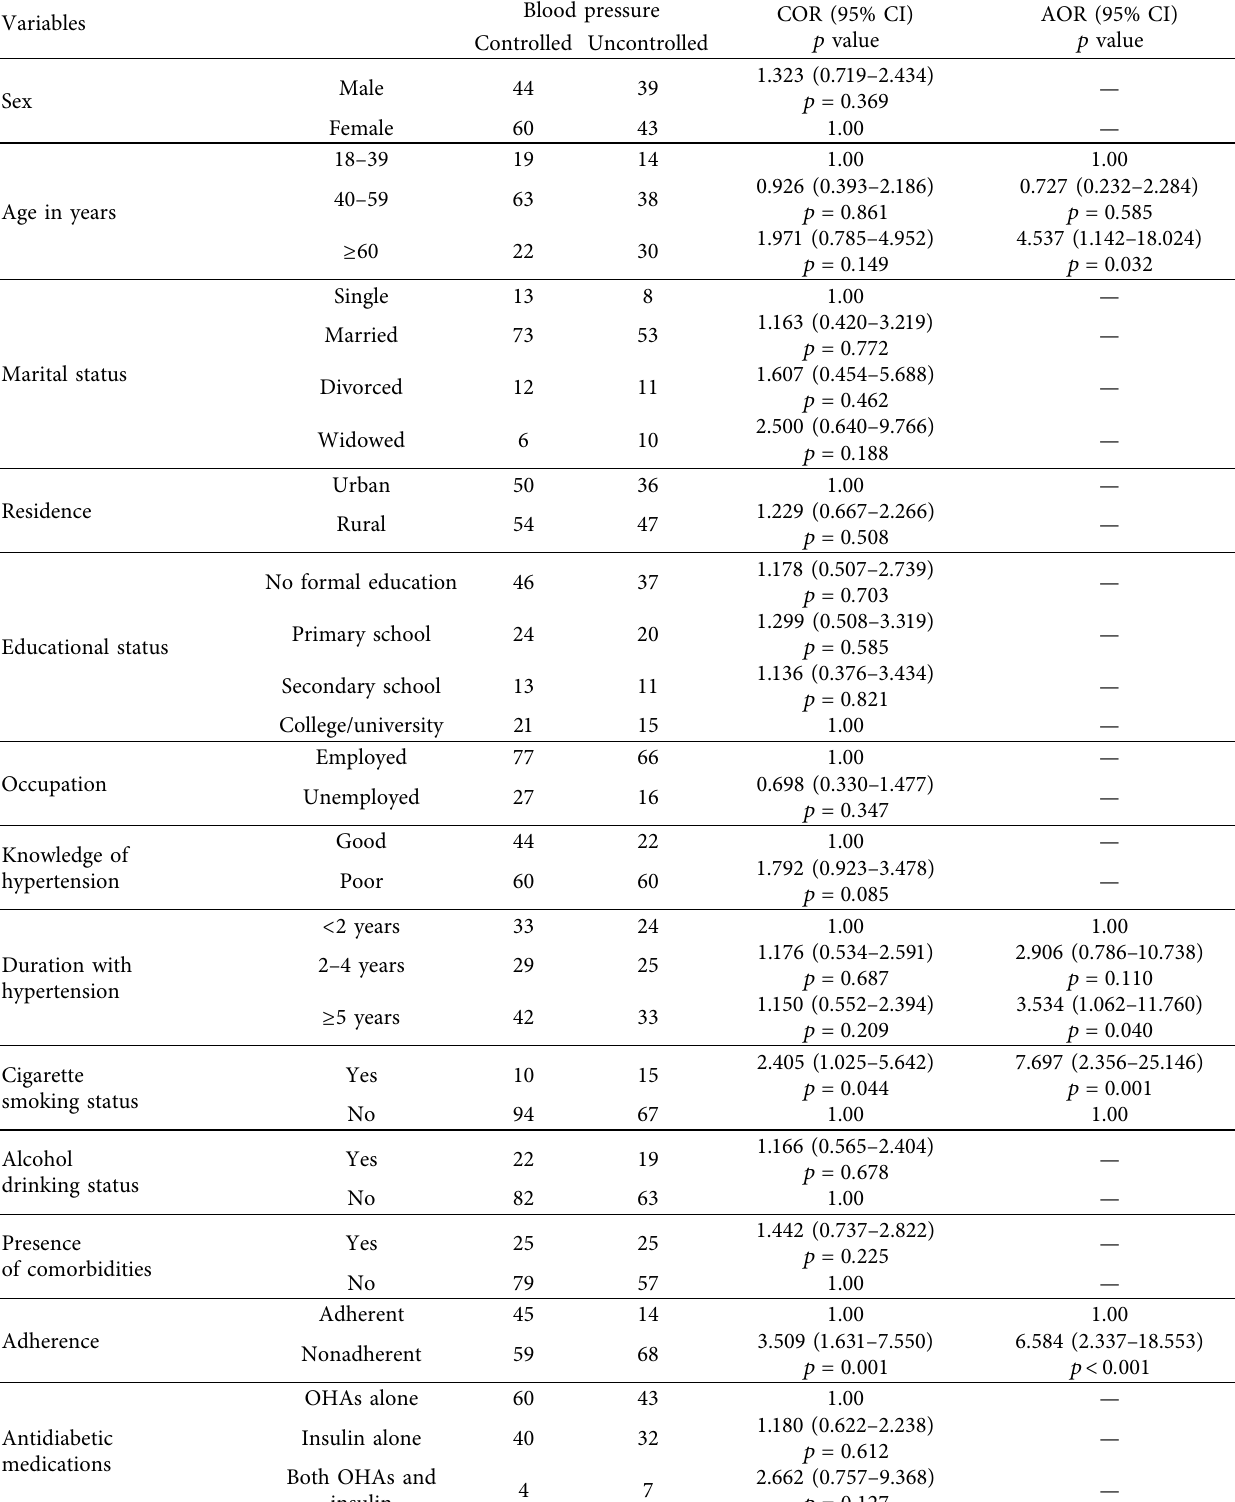
Table 2: Bivariable and multivariable analysis of factors associated with uncontrolled BP among hypertensive diabetic patients on follow-up at NRH, West Ethiopia, 2018 ( n �